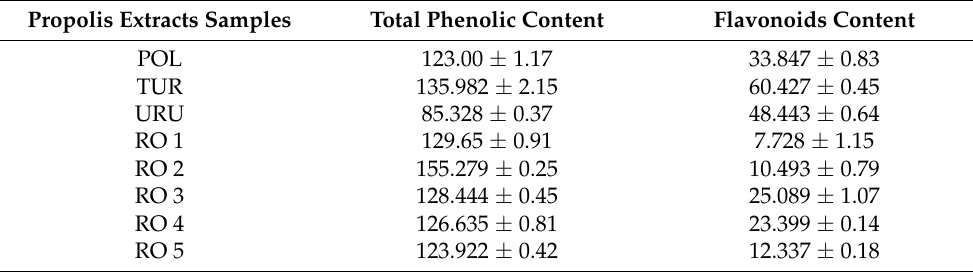
Table 1. Total phenolic content and flavonoids in propolis extracts [mg/g dry extract]. Propolis Extracts